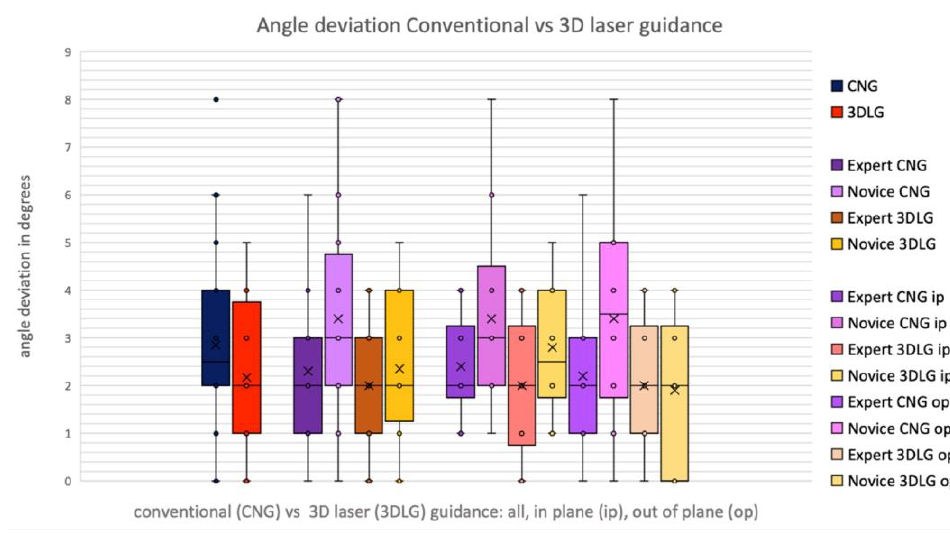
Figure 7. Angular deviation for conventional needle guidance (CNG) and 3D laser guidance (3DLG), for expert and novice, in in-plane and out-of-plane procedures.